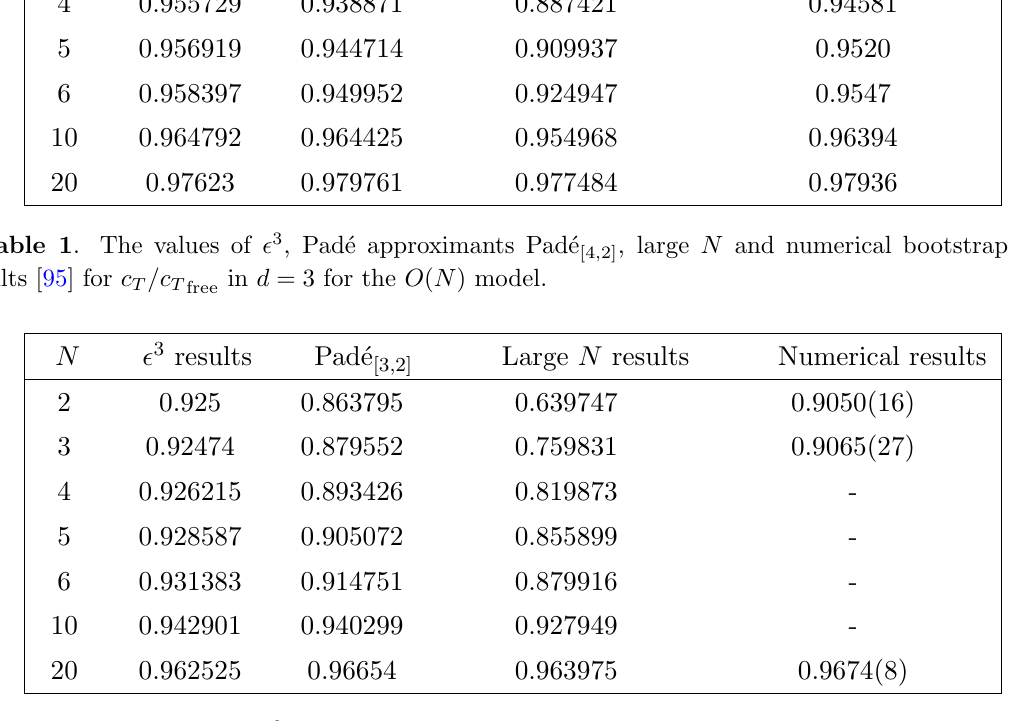
Table 2 . The values of (cid:15) 3 , Pad(cid:19)e approximants Pad(cid:19)e , large N and numerical bootstrap re- [3 ; 2] sults [96] for c J =c J in d = 3 for the O ( N ) model. (Only numerical results which were precisely free computed in [96] have been presented.) For N = 2 quantum Monte Carlo [93] results quote the value 0.917 or 0.904 [94] depending on the extrapolation scheme